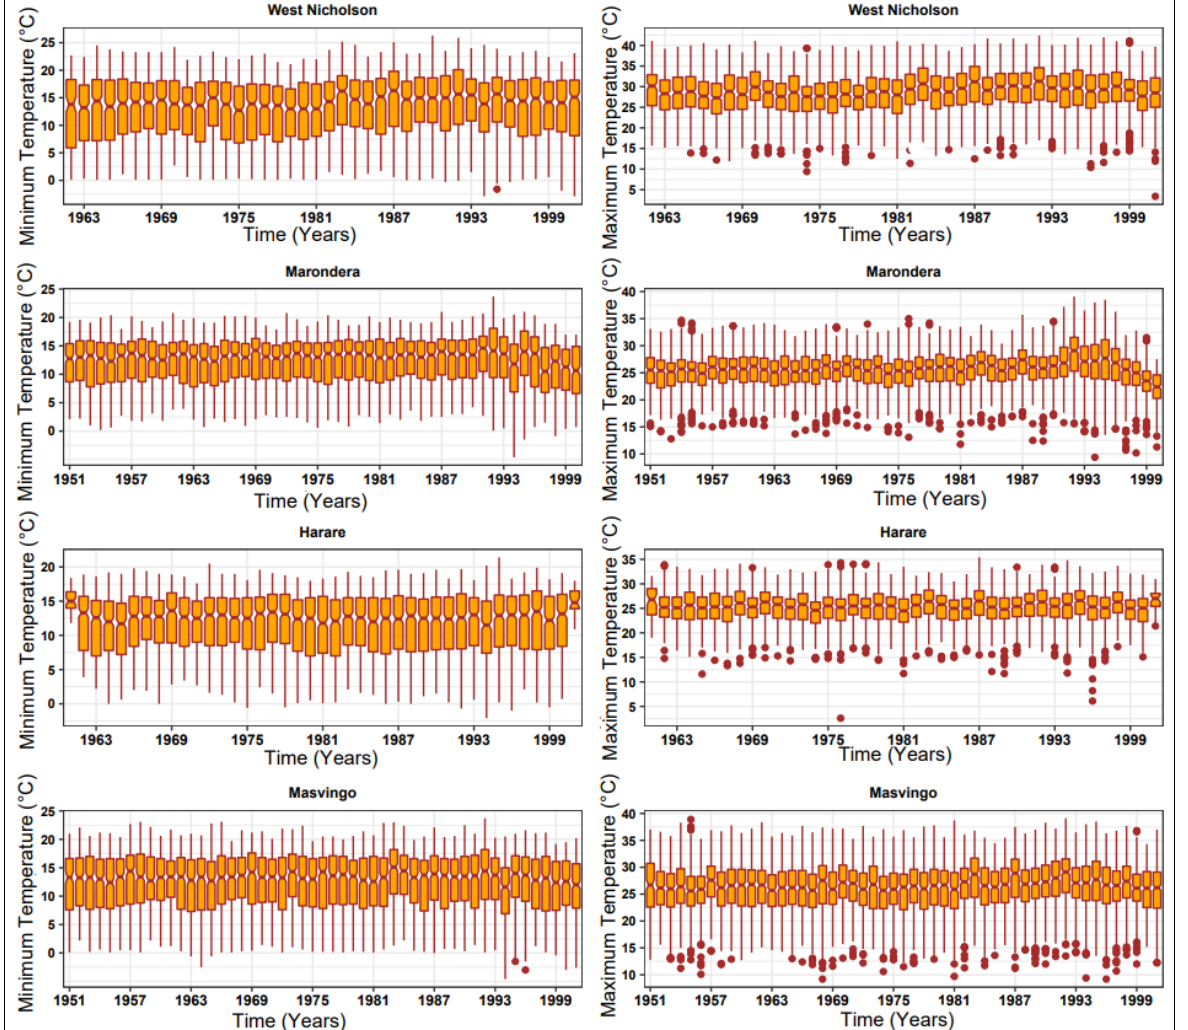
Figure 5. Minimum and maximum temperature trends at four locations in Zimbabwe over varying periods between 1951 and 2001.